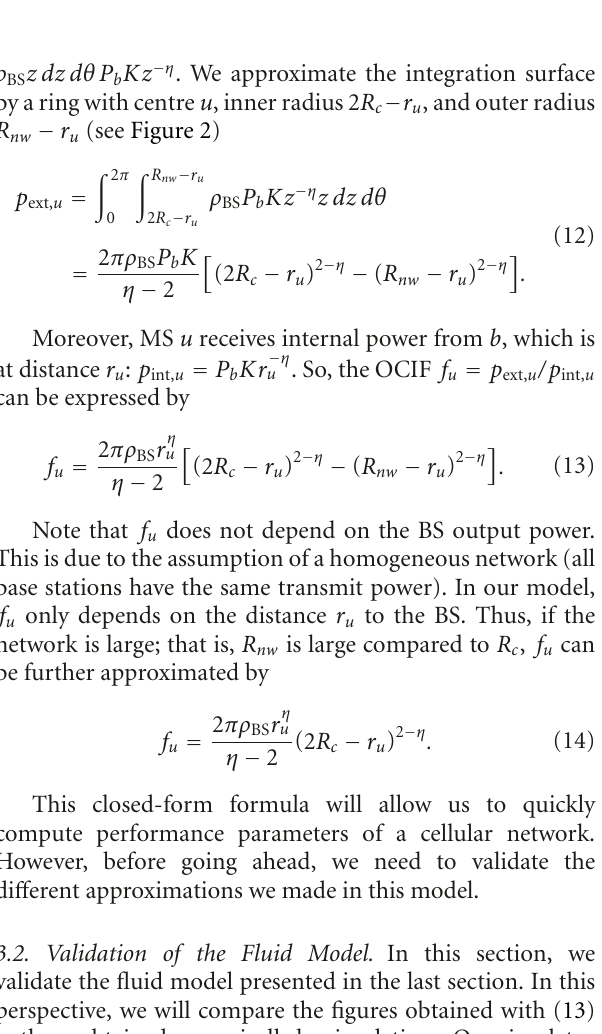
Figure 2: Integration limits for external interference computation.